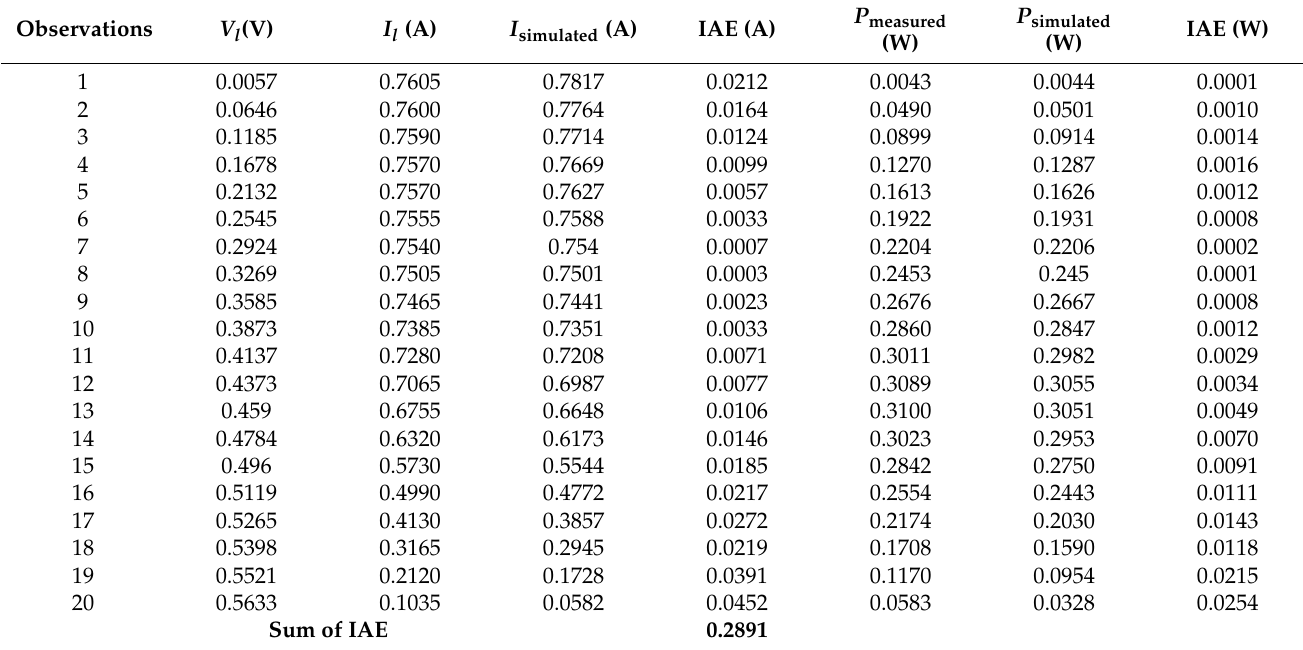
Table 2. The calculated current and absolute error results of the STO for SDM of the R.T.C France solar